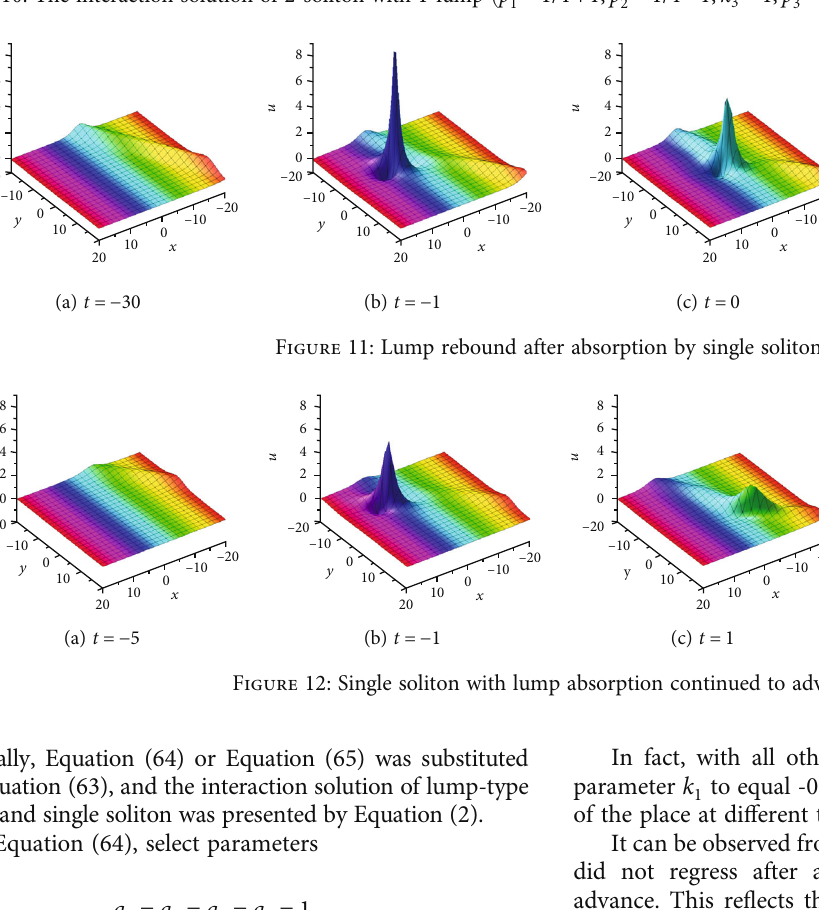
Figure 10: The interaction solution of 2-soliton with 1-lump ð p